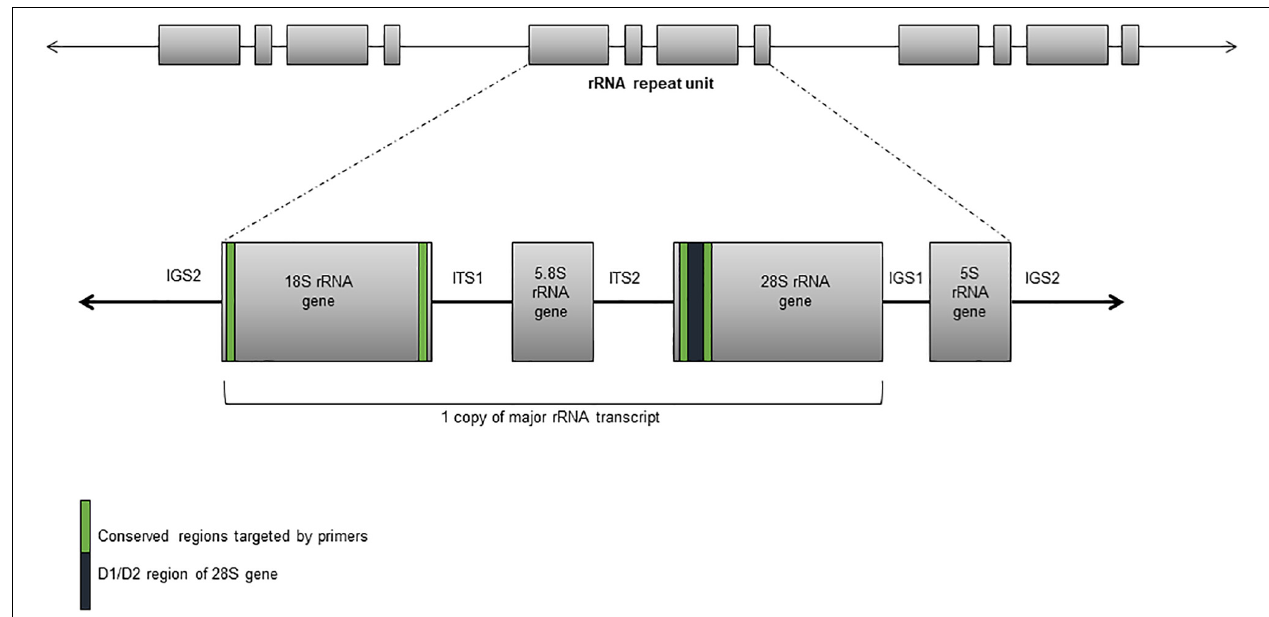
FIGURE 1 | Ribosomal RNA gene cluster comprising the 18 S , 5.8 S , and 28 S rRNA subunit genes, and separated by the internal transcribed sequences and the intergenic spacers.